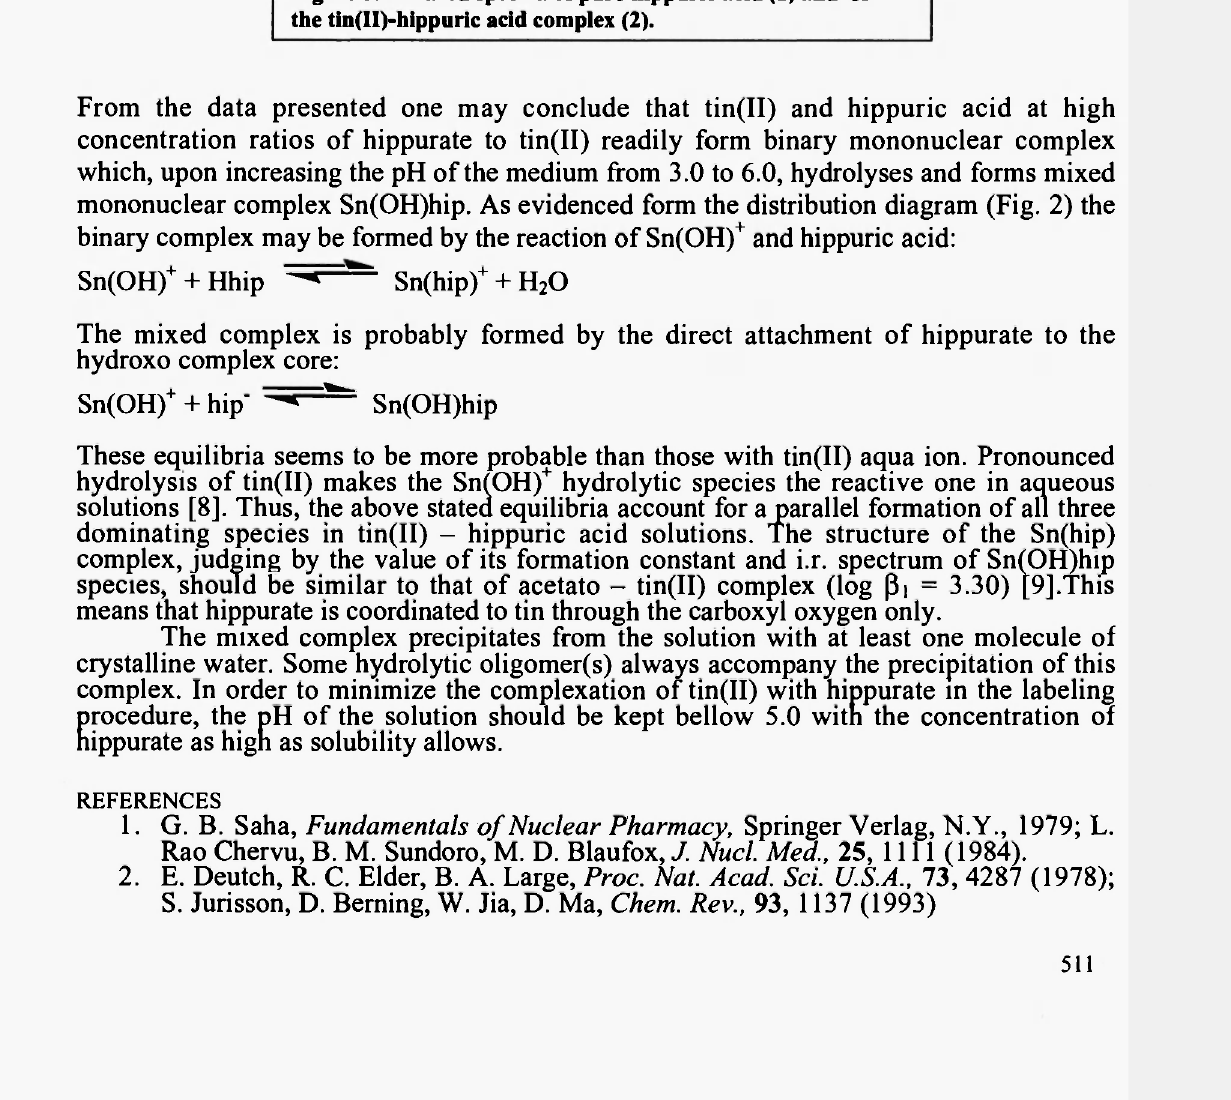
Figure 5. Infrared spectra of pure hippuric acid (1) and of the tin(II)-hippuric acid complex